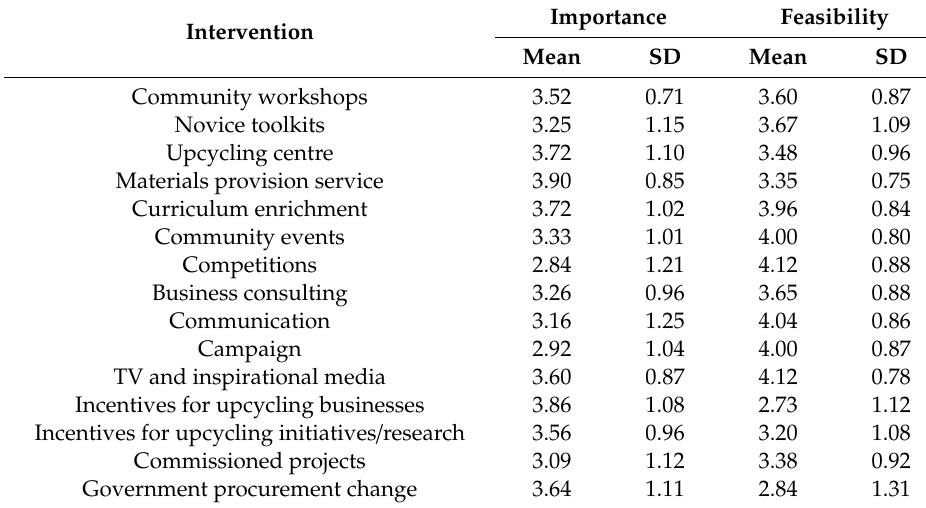
Table 4. Importance and feasibility of each